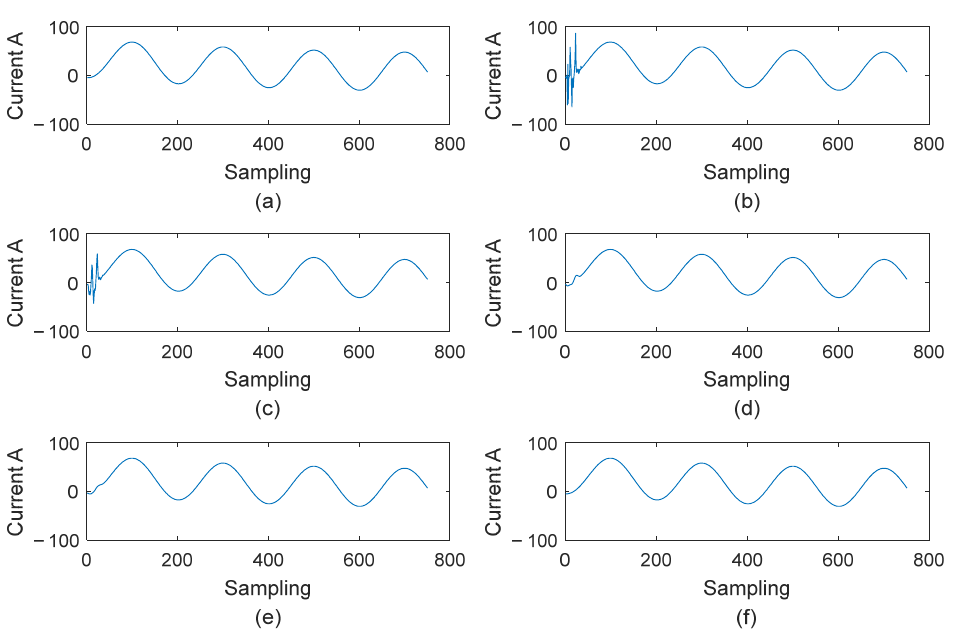
Figure 6. Trend filtering technology eliminates high-frequency interference of short-circuit current. ( a ) Ideal waveform without any interference. ( b ) The addition of the high frequency interference to the ideal waveform. ( c ) One-time filtering effect. ( d ) Fifteen filtering effect. ( e ) Thirty filtering effect. ( f ) Forty-five filtering effect.